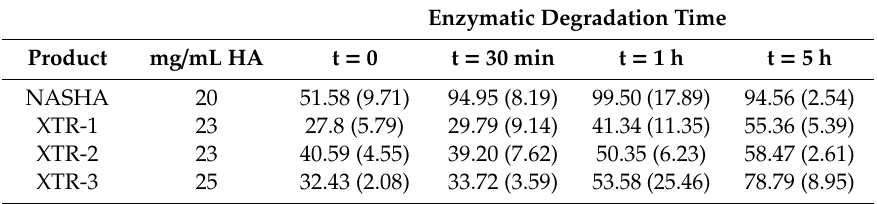
Table 4. Soluble fractions (mean and standard deviation) for each of the HA fillers evaluated.